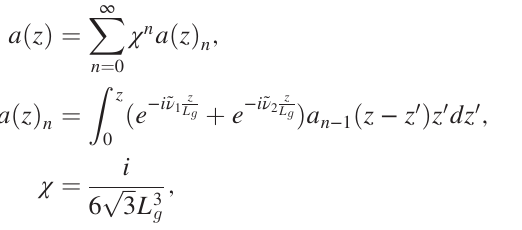
FIG. 1. Gain function G ð ν 1 ; ν 2 Þ , derived from Eq. (3), versus the detuning parameter. The function is plotted for different values of the frequency separation in the case of an undulator with a number of periods N ≅ 460 , being ρ ≅ 10 − 4 the Pierce parameter and Δ ω = ω the relative separation between the resonant frequencies corresponding to the two different electron energies. The dotted curve in (b) represents the ordinary gain function − π g